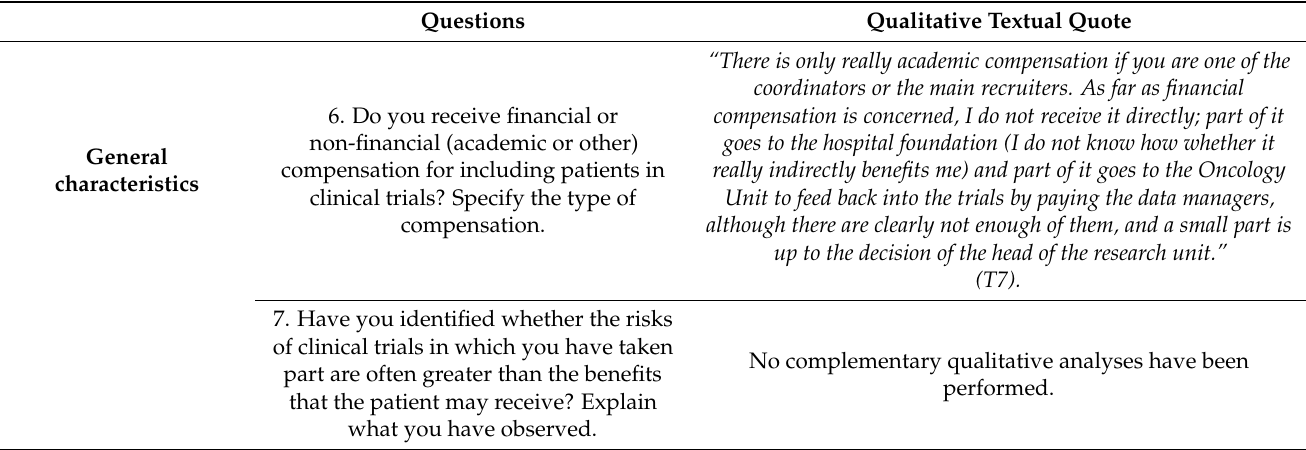
Table 3. Qualitative analysis of the assessment of usual practice in the case of there being clinical trials in progress in your hospital. Galicia,